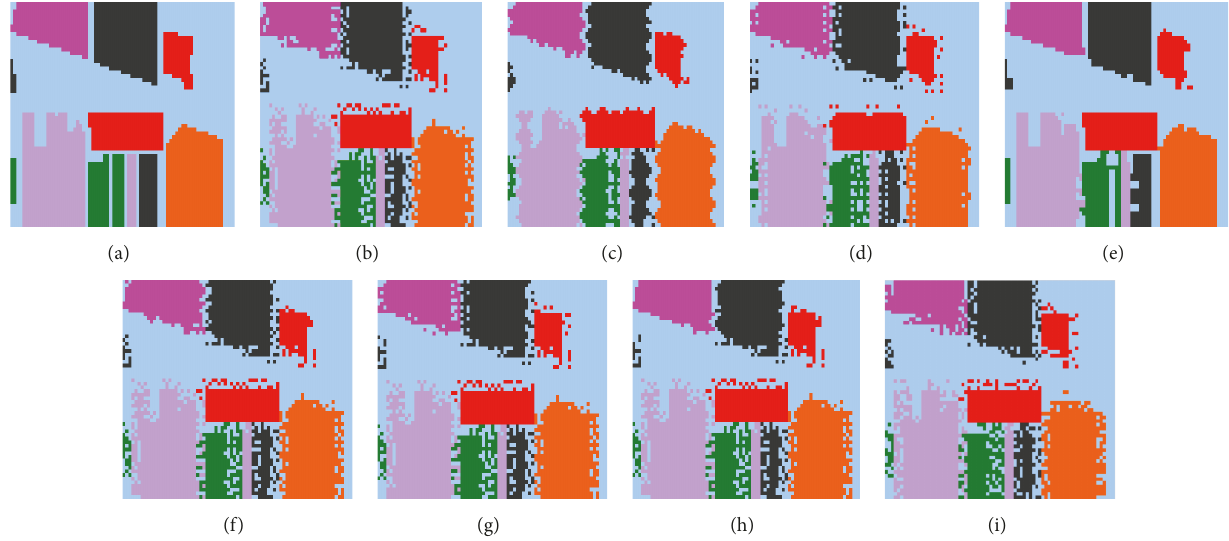
Figure 5: Subpixel mapping results with the six kinds of algorithms for Figure 4(b): (a) true distribution, (b) random distribution, (c) PMBQPSO, (d) CMBQPSO, (e) GMBQPSO, (f) PBQPSO, (g) CBQPSO, (h) GBQPSO, and (i) PSA.